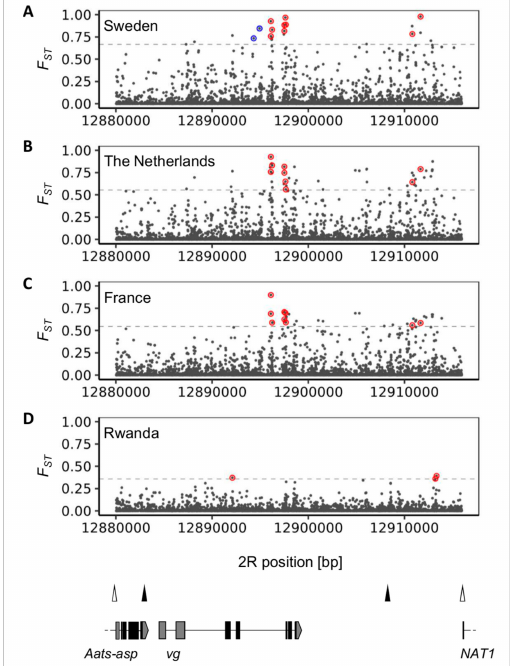
Figure 2. F ST per SNP across the vg gene region. F ST was estimated between the tropical Zambian population and each of the temperate populations. F ST between the populations from Sweden ( A ), The Netherlands ( B ), France ( C ) and the tropical, ancestral range population from Zambia. Outlier SNPs shared between all European populations are encircled in red. Dashed lines correspond to the respective 99 th quantiles. Outlier SNPs between the Swedish and Zambian population samples and that are also highly di ff erentiated between the Swedish and each of the other three temperate populations (TOP5%) are encircled in blue. ( D ) F ST between the Rwandan and the Zambian population samples. Outlier SNPs are encircled in red. The dashed line corresponds to the 99.9 th quantile. The bottom diagram depicts the vg gene region. Coding regions are represented by black boxes, untranslated regions by gray boxes, and introns by black lines. Arrowheads indicate the direction of transcription and positions of insulators are given by